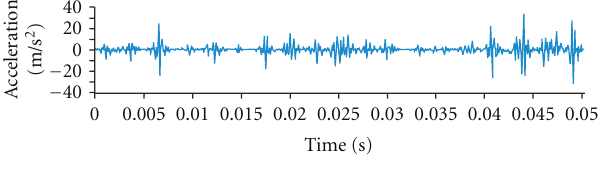
Figure 9: De-noised signal of vibrations of a gear with a pinion with a crack with SURE threshold.